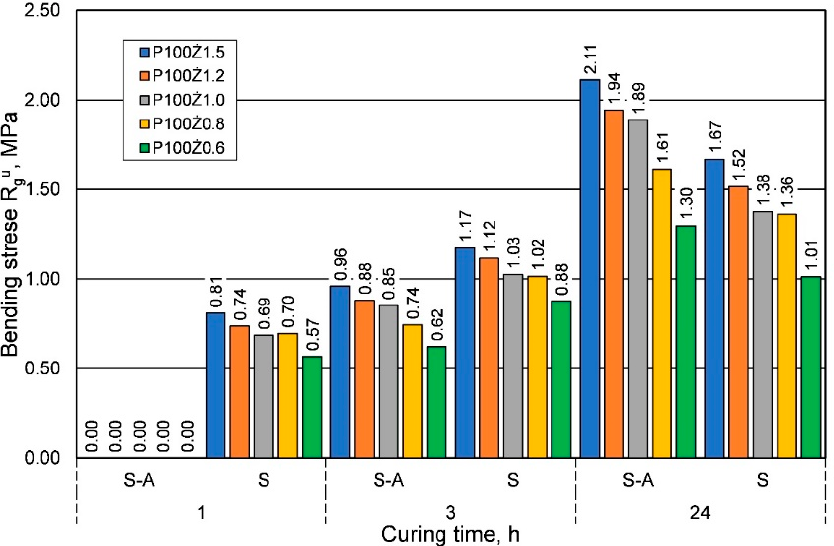
Figure 4. Bending strength R u g of molding sand based on fresh chromite sand, depending on weather conditions, for different amounts of binder added.